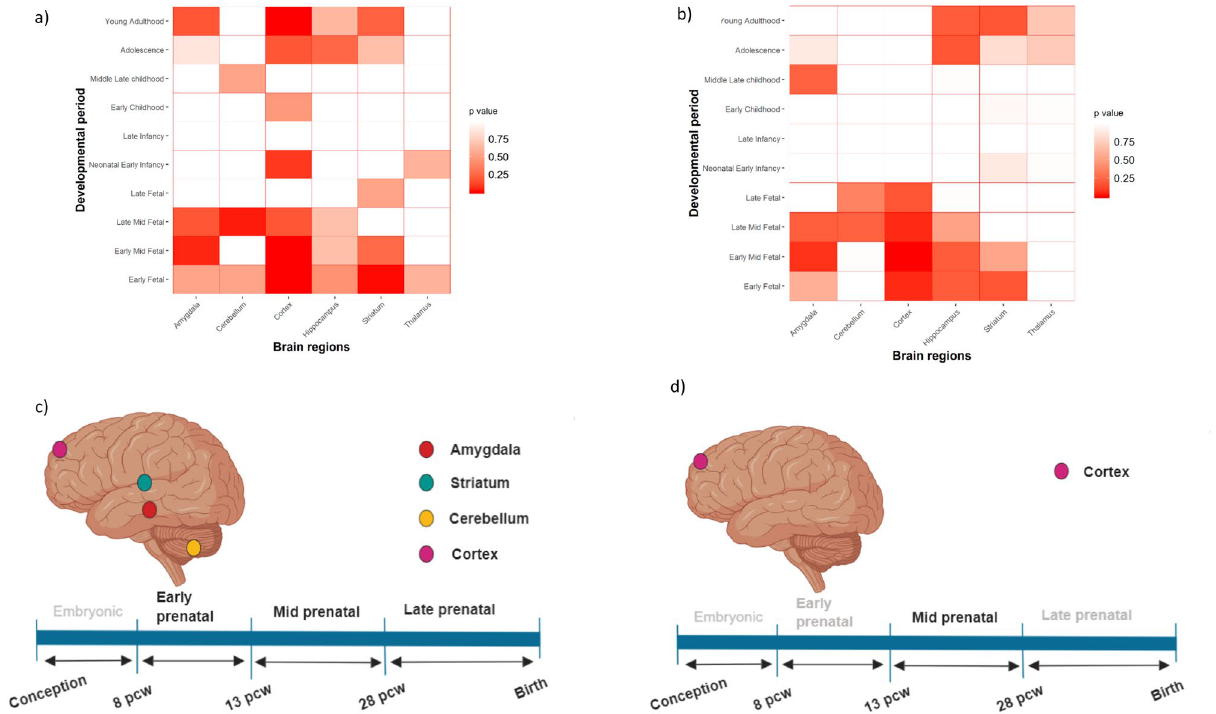
Figure 6. Expression analysis across developmental stages and brain areas for germinal and PZMs genes from the combined cohort. Expression gene sets were obtained from BrainSpan. ( a , c ) Expression of germinal genes across different brain regions and developmental periods. ( b , d ) Expression of PZMs genes across different brain regions and developmental